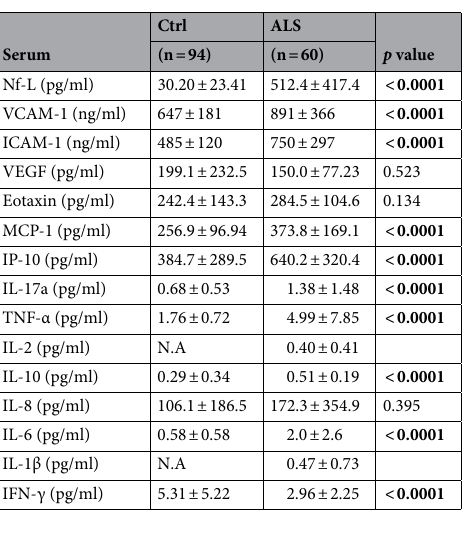
Table 1. Biomarkers levels in serum of patients with ALS and control group (Ctrl). Significant Mann Whitney p values are indicated in bold.